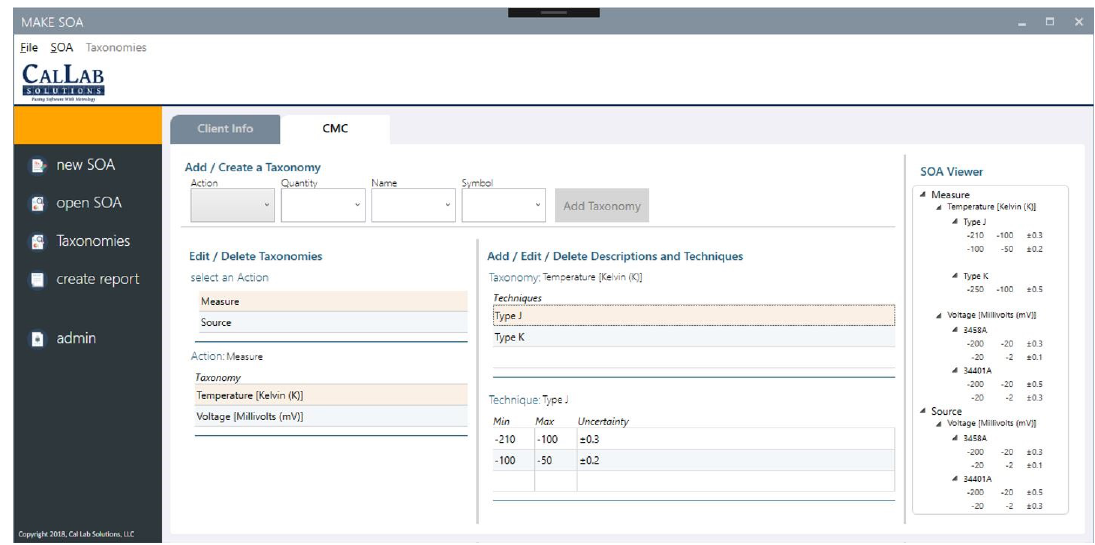
Figure 9. A screenshot from the SoA editor desktop application.